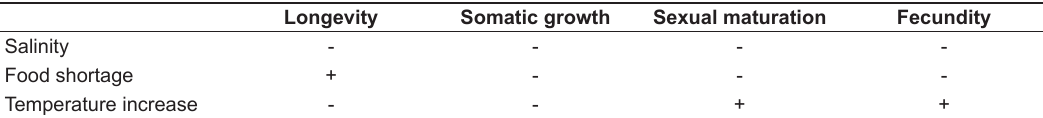
Figure 3. An example of a whole-lifespan life table experiment with Moina macrocopa exposed to different concentra- tions of humic substances (HSs = 0, 5 and 10 mg dissolved organic carbon L -1 ). a) Body length at primipara (sexual maturity), b) total offspring per female, c) % of male offspring per female and d) Survival curves. Different lower-case letters denote statistical differences between treatments (Modified from Suhett et al., 2011). Table 1. Summary of the consequences of stress caused by different environmental factors (stressors) to specific life history traits of